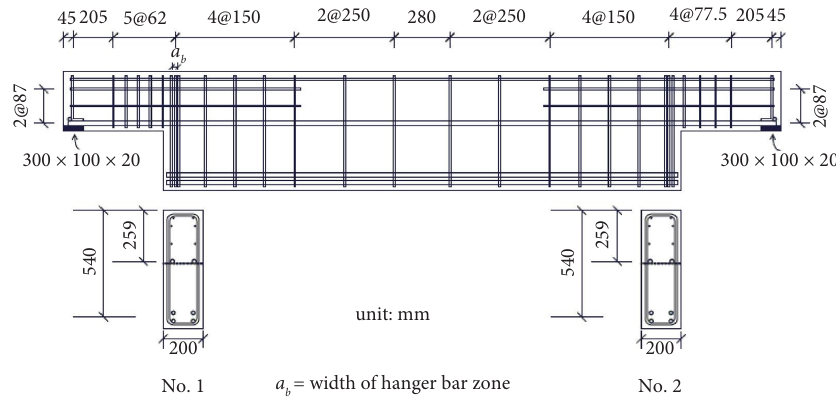
Figure 1: Test beam cross-section [16].